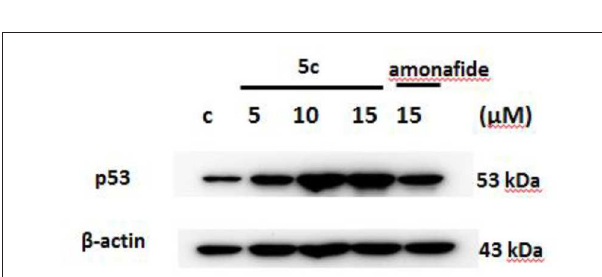
FIGURE 5 | The expression of p53 in Snu-739 cells after treatment with 5c and amonafide.